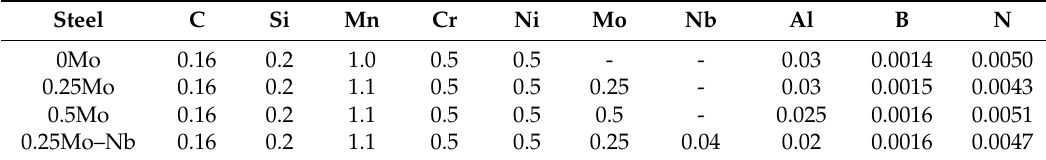
Table 1. Chemical compositions of investigated steels in wt.%.